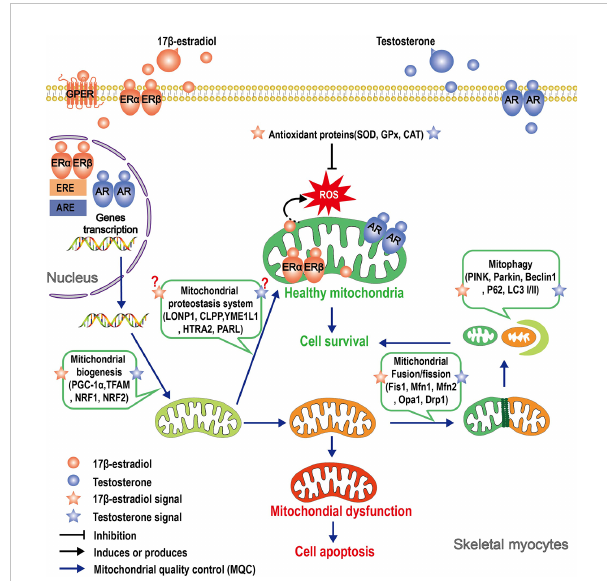
FIGURE 2 Schematic illustrating the roles that 17 b -estradiol and testosterone play in mitochondrial protection of skeletal myocytes. Signals of 17 b -estradiol and testosterone affect mitochondria function through multiple pathways. In the genomic pathway, 17 b -estradiol or testosterone binds to its receptor, thereby inducing receptor dimerization and translocation of the entire complex to the nucleus. In the nucleus, the dimer of the receptors binds to estrogen response elements (ERE) or androgen response elements (ARE) and affects the transcription of nuclear-encoded mitochondrial genes. ERs and AR have been shown to localize in mitochondria, but it is yet unclear if the complex can directly regulate the transcription of mtDNA-encoded genes. The “ nongenomic pathway ” involves rapid activation of various kinases by membrane-associated ERs or AR, which in turn can affect mitochondrial function. Both 17 b -estradiol or testosterone regulate different parameters of MQC, such as proteostasis, biogenesis, dynamics, and mitophagy. A consequence of the action of these sex hormones is mitochondrial protection, although the speci fi c mechanism of action has not yet been